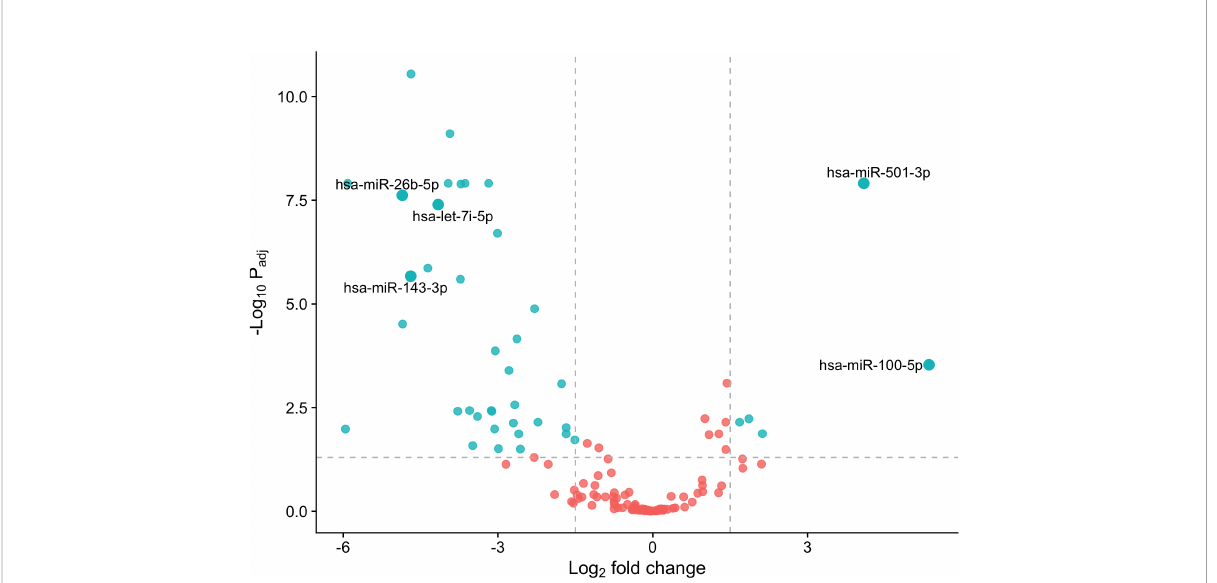
FIGURE 2 DE miRNAs in the T1DM patients in comparison to controls. Blue dots are considered DE miRNAs under the conditions of adjusted values of p < 0.05 and |log2 fold change| ≥ 1.5. Red dots are non-DE miRNAs. Note that miRNAs on right of fi gure are up-regulated, and on the left are